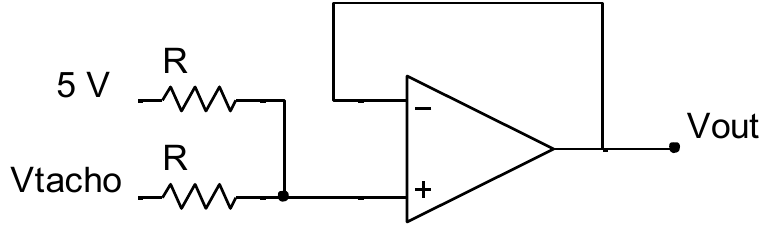
Fig. 13. Signal conditioning circuit for the